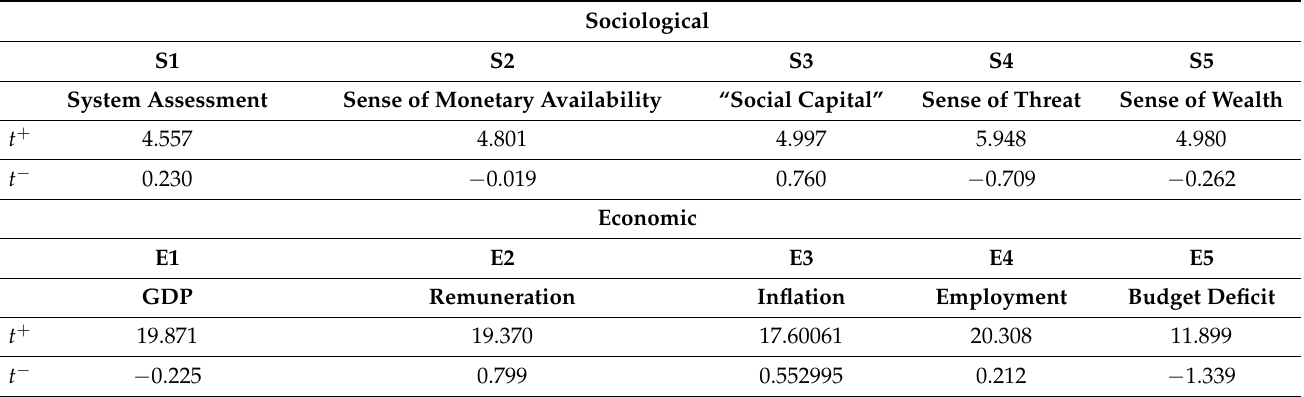
Table 4. Values of indicators of significance ( t + ) and relationship ( t − ) for each KPI